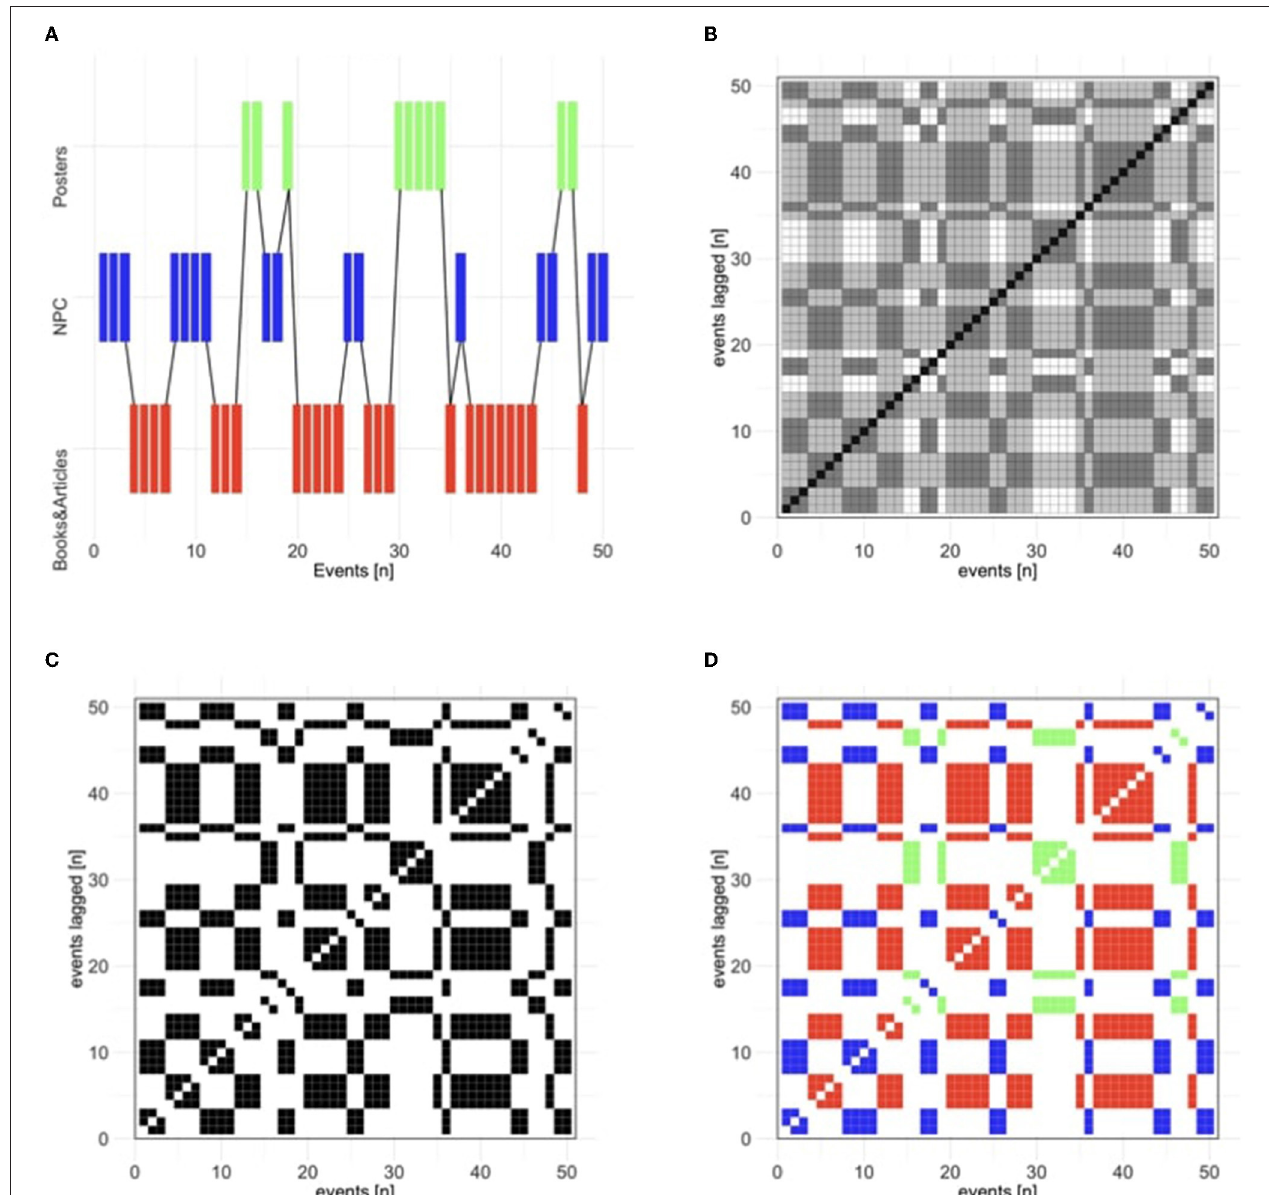
FIGURE 1 | (A) Time series of events in the chronological order (or events on the main diagonal) that are transformed into the (B) distance matrix, (C) recurrence plot, and finally, into the (D) color-coded recurrence plot (Books in red, NPC in blue, and Posters in green).